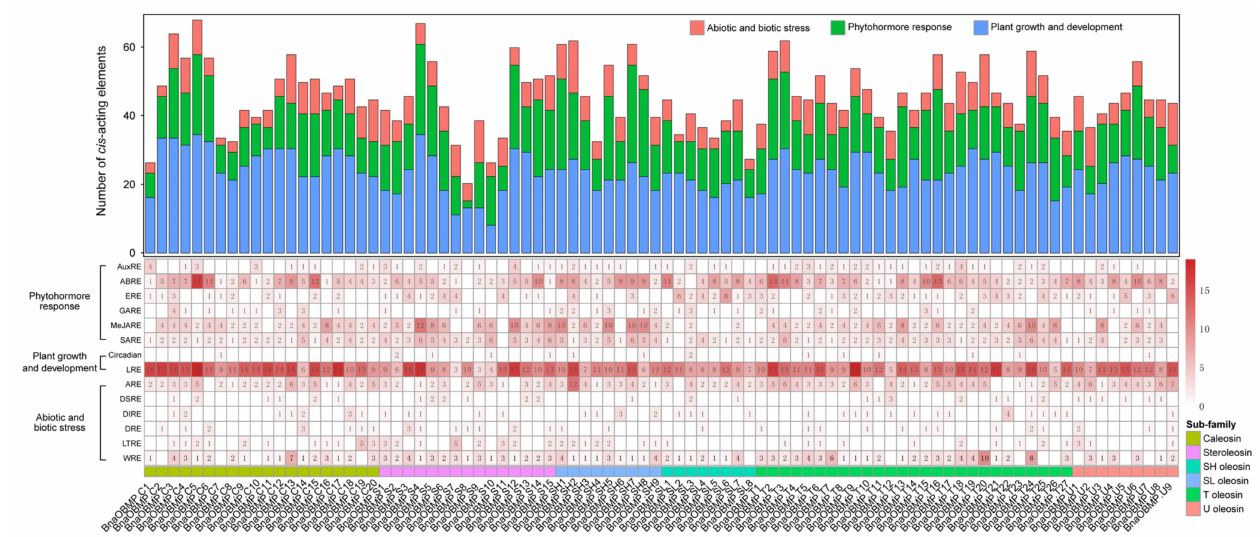
Figure 4. Cis-acting regulatory elements in the promoter region of BnaOBMP Genes. The upper panel of the bar plot represents the total number of cis-acting regulatory elements in each gene promoter region. The bars with different colors represent different types of cis-acting regulatory elements involving in abiotic and biotic stress response (red), phytohormone response (green) and plant growth and development (blue). The lower panel of the heatmap indicates the numbers of various cis-acting regulatory elements in these BnaOBMP genes. The color intensity of the cell denotes the number from low (white) to high (red). The numbers are displayed in the cells. The different OBMP gene subfamilies are marked by corresponding colors that are shown in the color legend at the bottom